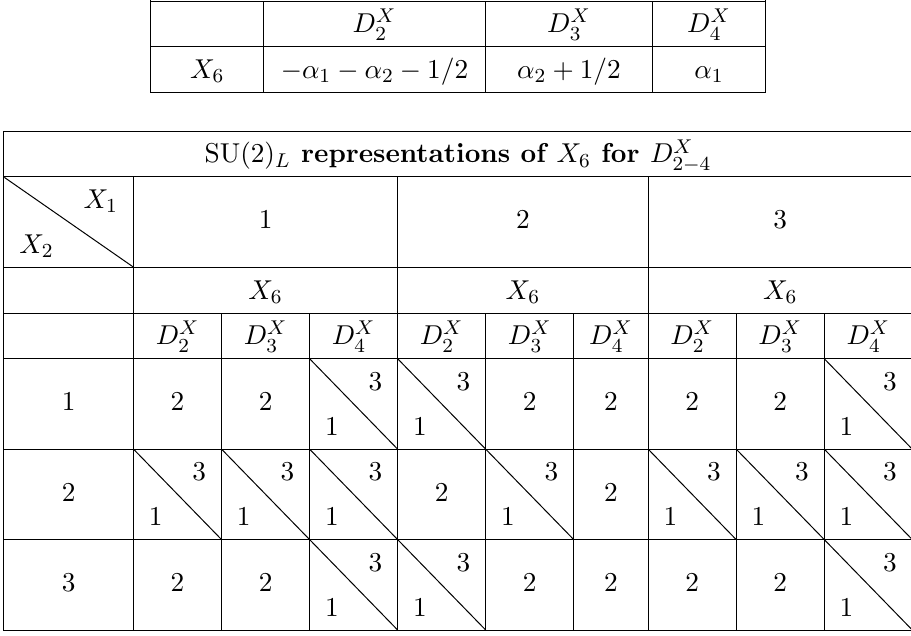
Table 4 . Standard Model quantum numbers for the (cid:12)eld X 6 of the diagrams D X in (cid:12)gure 8. Two input (cid:12)elds are needed X 1 and X 2 with hypercharges (cid:11) 1 and (cid:11) 2 , respectively, and SU(2) L representations explicitly given in the (cid:12)rst row and column of the second table. These tables should be completed with table 1 which contains the quantum numbers for the (cid:12)elds X 3 , X 4 and X 5 , common for all the diagrams. For simplicity, all the (cid:12)elds are colour singlets.